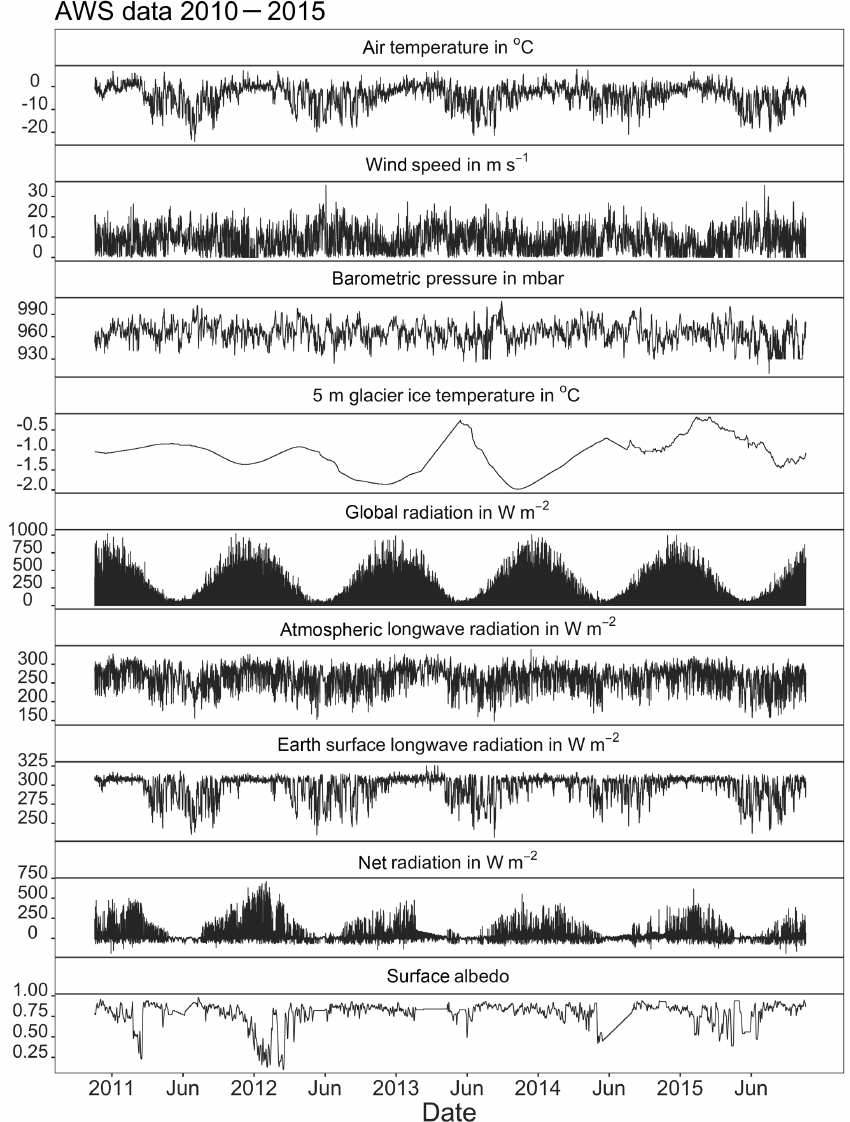
Figure 4. Meteorological time series (gap-filled) aggregated to hourly resolution at the AWS site on the Fourcade Glacier, King George Island, during the time period November 2010–November